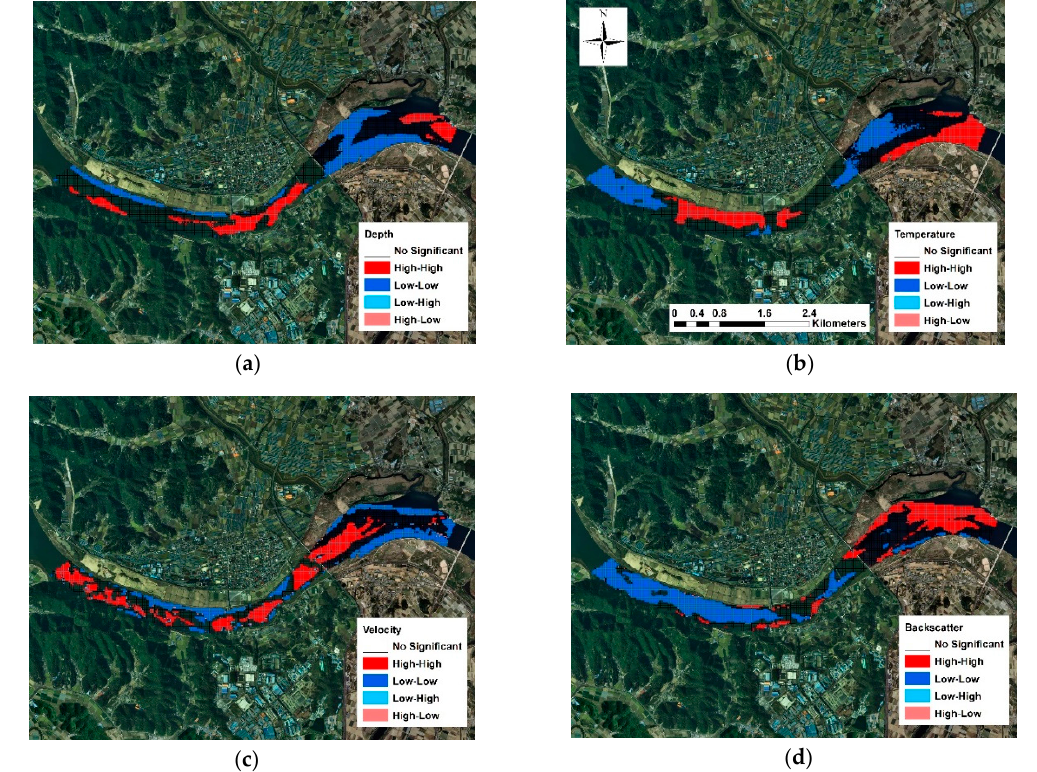
Figure 6. SpatialcorrelationmapsapplyingtheLISAmethodtotheADCPmeasurements, wherehigh-high Figure 6. Spatial correlation maps applying the LISA method to the ADCP measurements, where